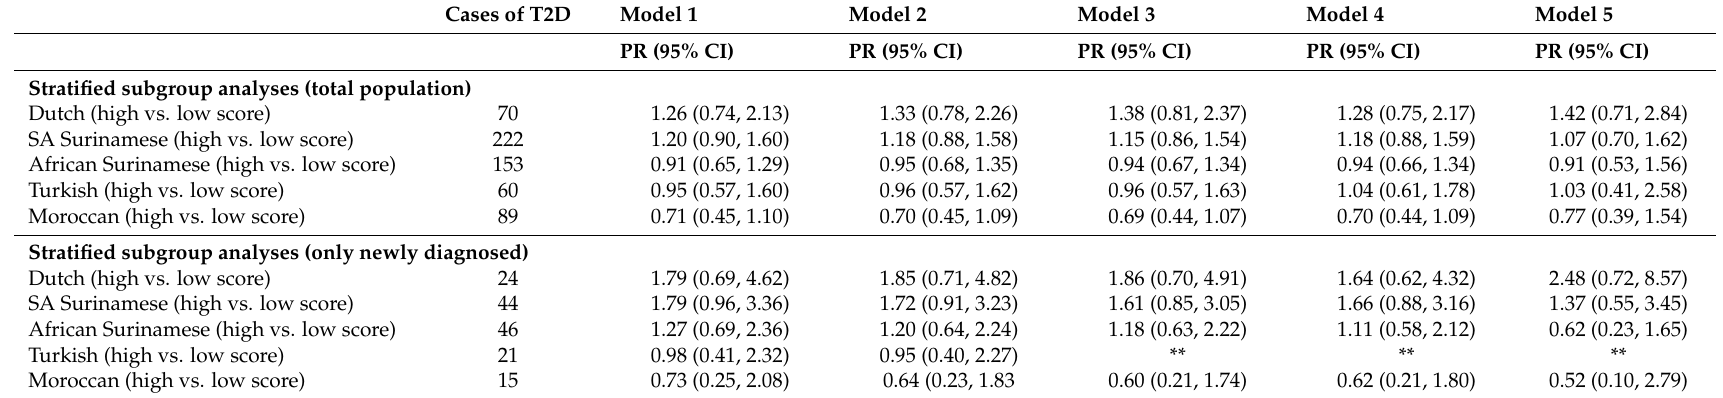
Table A2. Stratified subgroup analyses for the association between HSHF dietary pattern score and